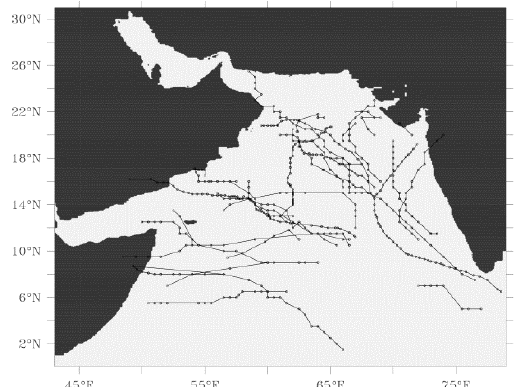
Figure 1. Tracks of tropical cyclones observed between 2003- 2018 in the Arabian